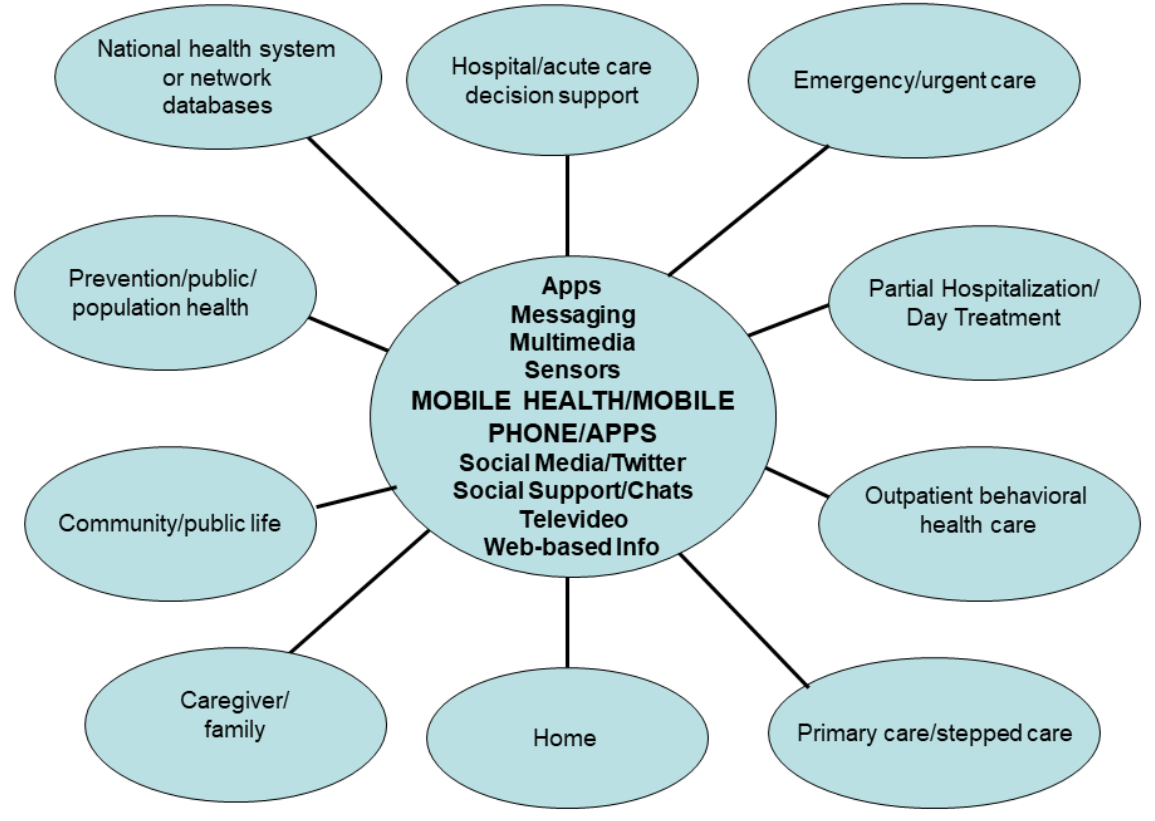
Figure 1. How mobile health, mobile phone/device, and apps integrate information in the digital